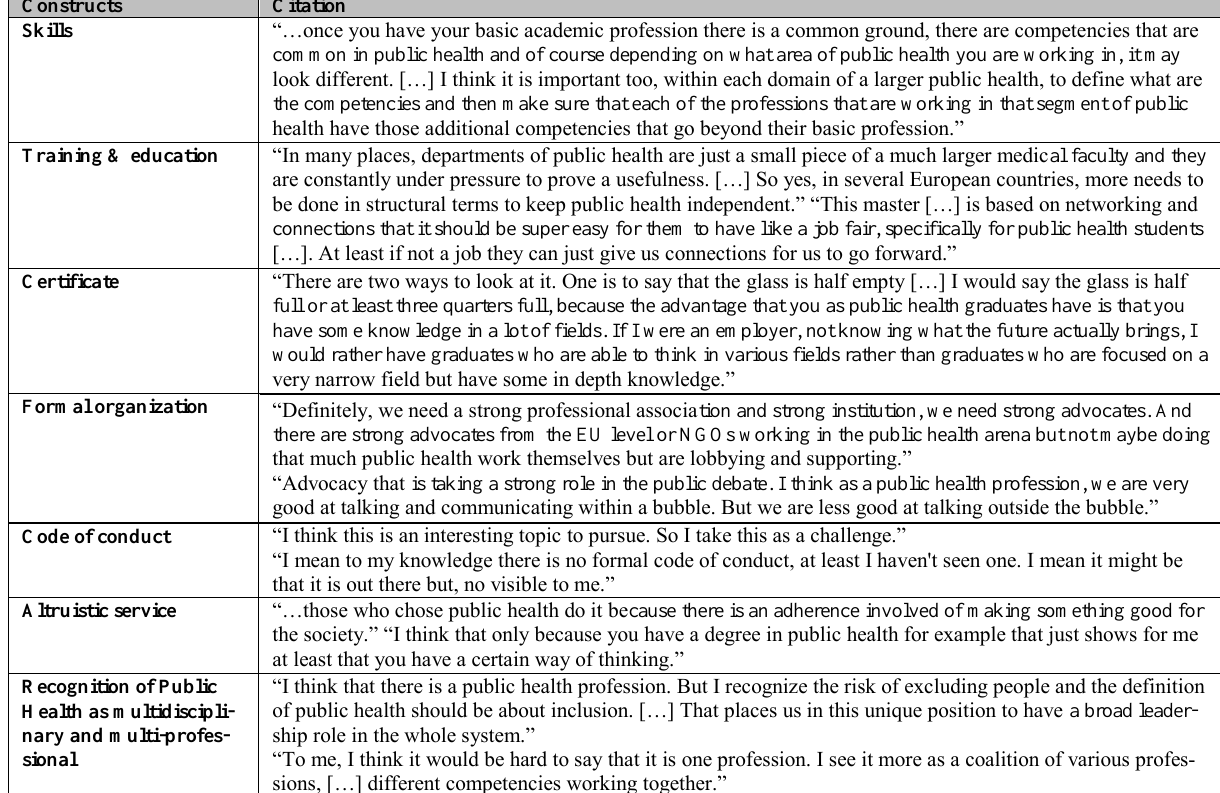
Table 3. Excerpts from the focus groups and expert interviews assigned to the six theoreti- cal constructs related to professionalization advanced with a new derived